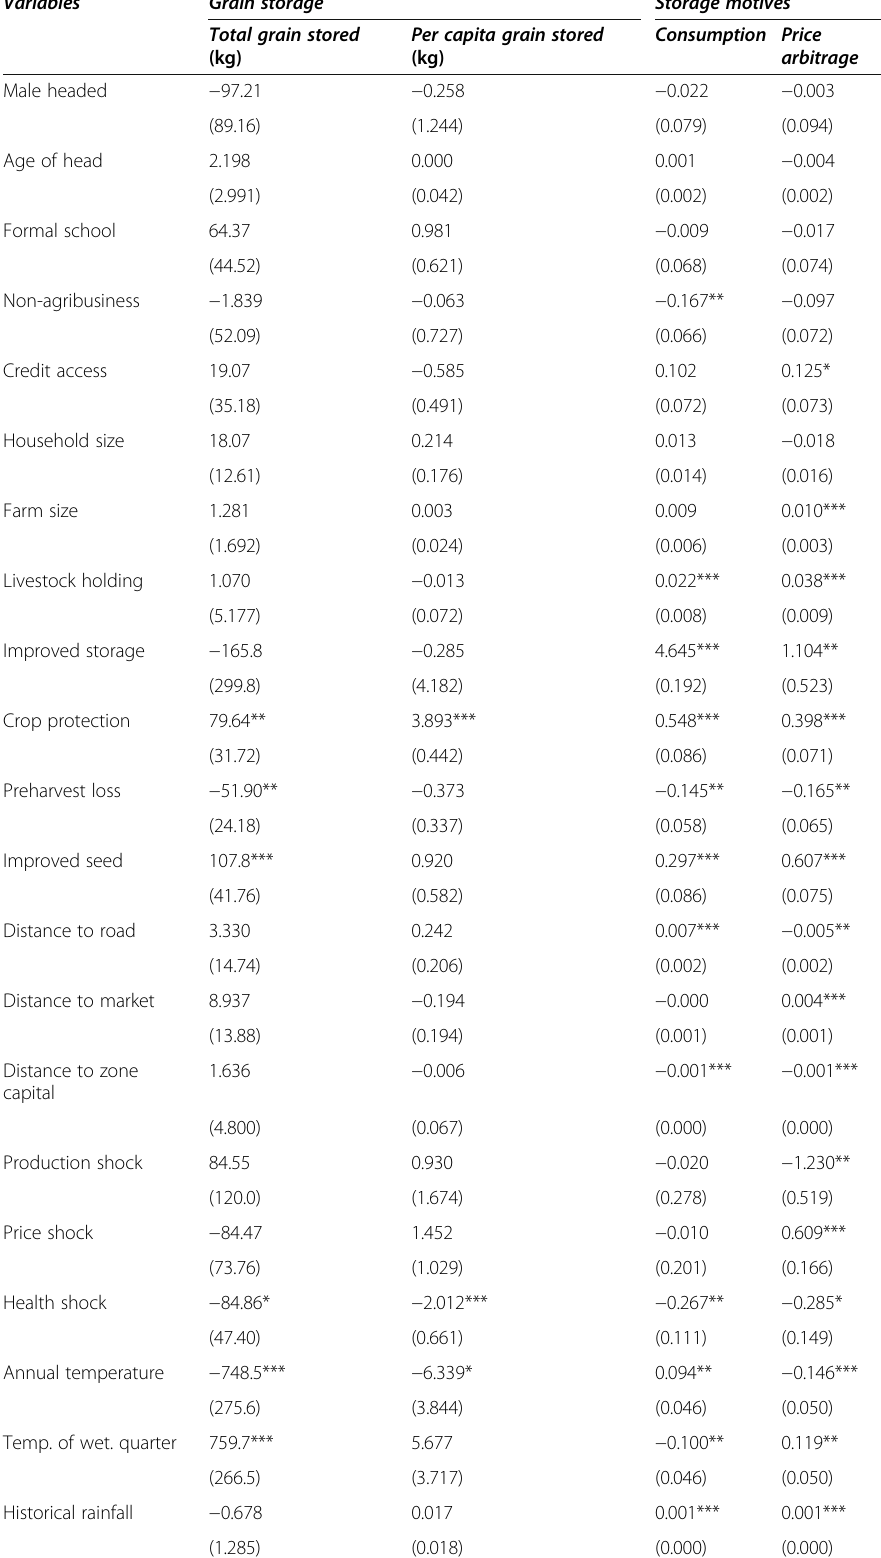
Table 4 Determinants of maize storage and storage